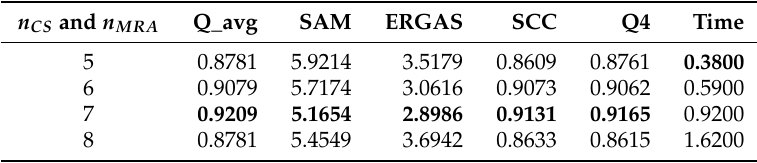
Table 3. Quantitative results and running time with different number of the averaged methods.